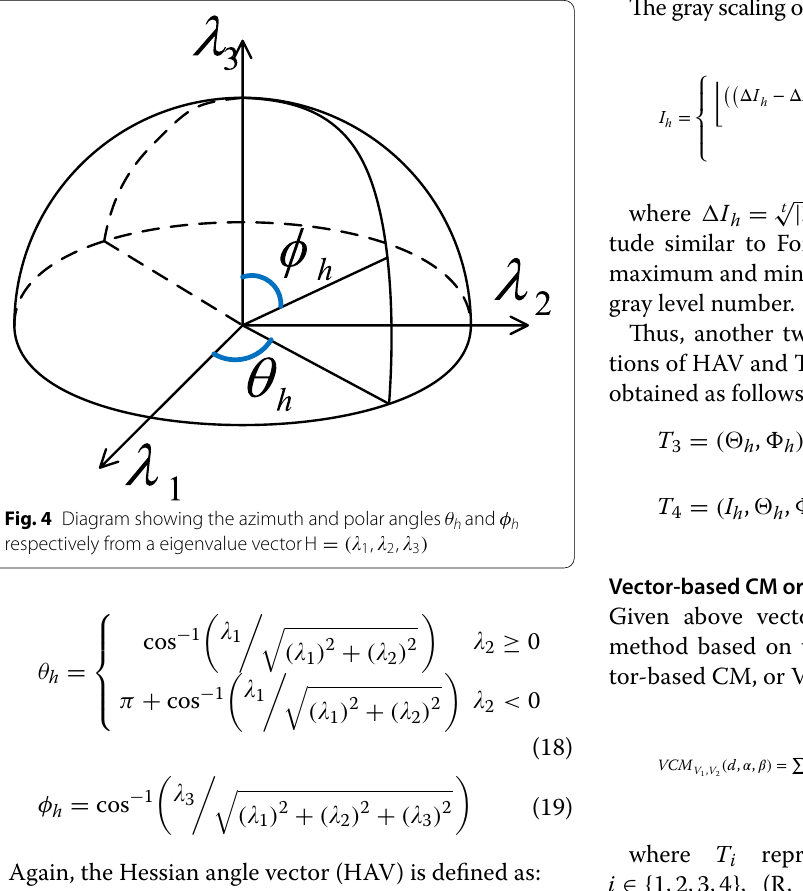
Again, the Hessian angle vector (HAV) is defined as: